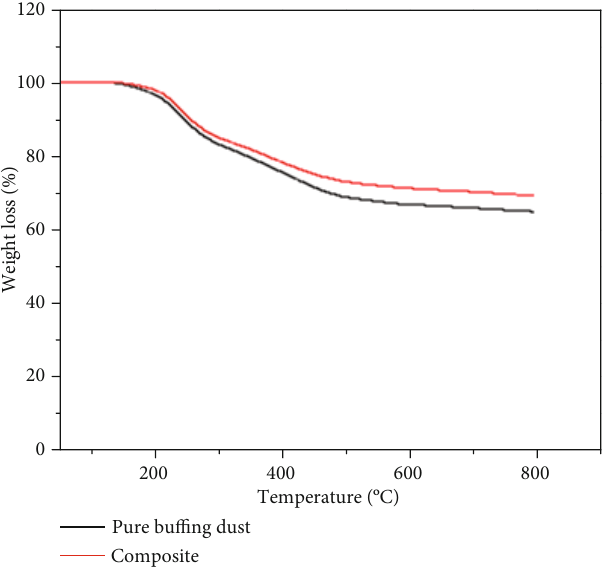
Figure 4: TGA of pure bu ffi ng dust and composite.